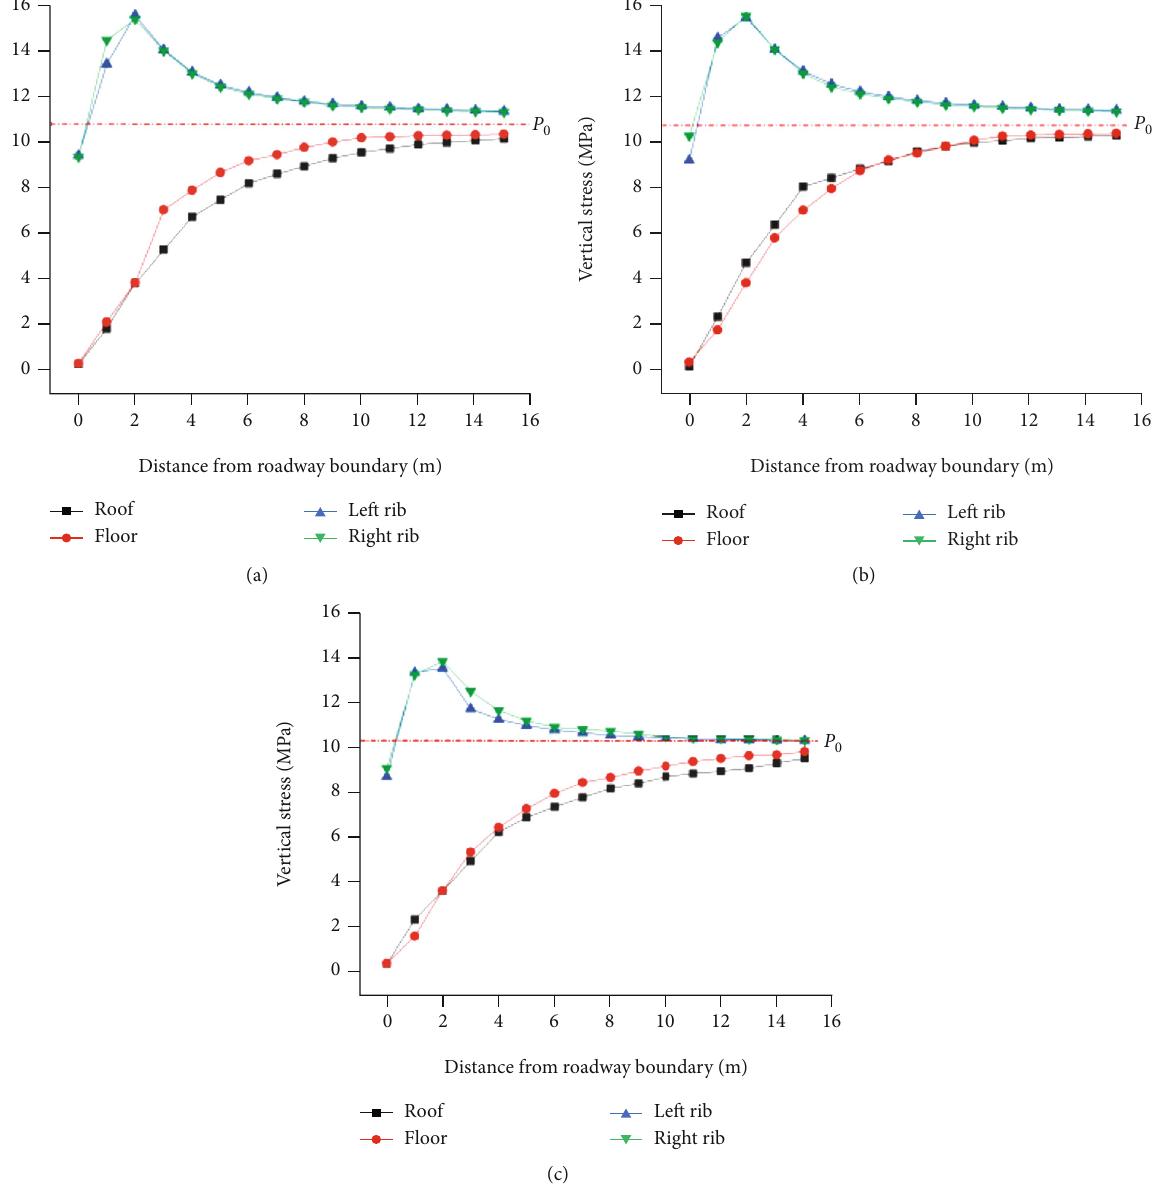
Figure 7: Vertical stress change curve under di ff erent support methods. (a) No support. (b) Original support. (c) Combined